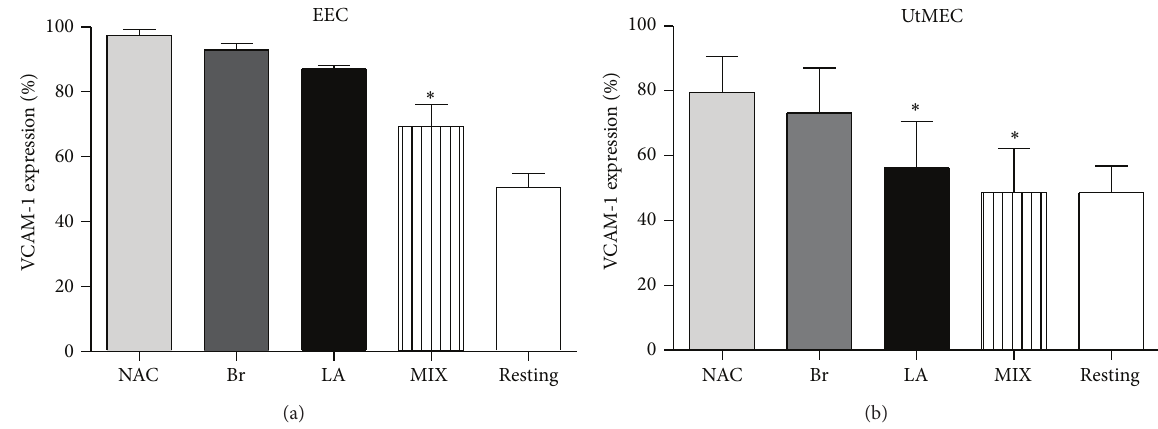
Figure 4: Anti-inflammatory effect of NAC/LA/Br on ECs: analysis of VCAM1 expression. Five different populations of endometriotic endothelial cells (EECs) and 5 different populations of uterine microvascular endothelial cell (UtMECs) were isolated, as described by Bulla et al. [17] with some modifications. ECs were grown to confluence in a 96-well plate and then incubated with NAC 10 𝜇 g/mL, AL 9 𝜇 g/mL, and Br 2 𝜇 g/mL, alone or in association (MIX). Successively the cells were stimulated overnight with TNF- 𝛼 (100ng/mL) and incubated with anti-human VCAM1. The binding of primary antibody was revealed incubating the cells with a goat anti-mouse IgG conjugated with alkaline phosphatase. The 100% of VCAM1 expression is referred to the TNF- 𝛼 -treated cells. Data are expressed as mean ± SE of results from five experiments each performed in triplicate. ∗ 𝑃 < 0.05 with respect to the untreated (Mann-Whitney